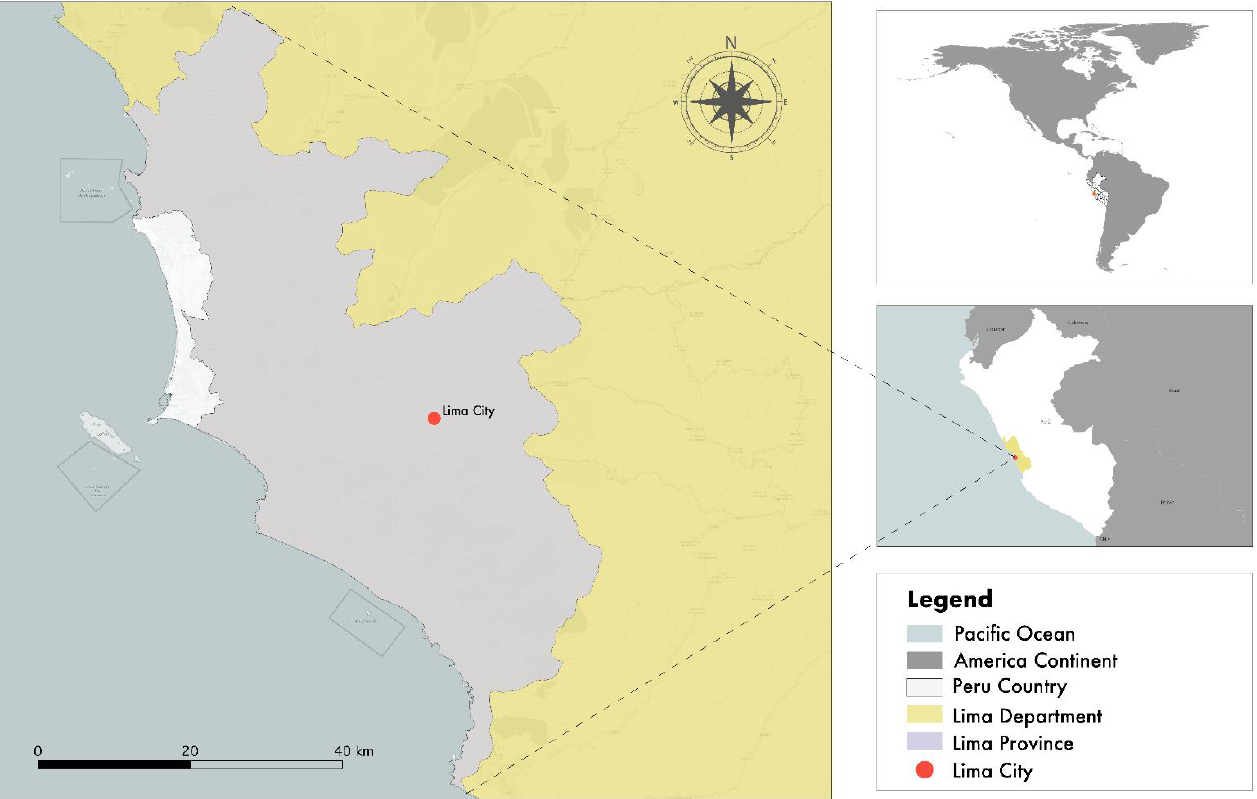
Figure 4. Location of Lima.